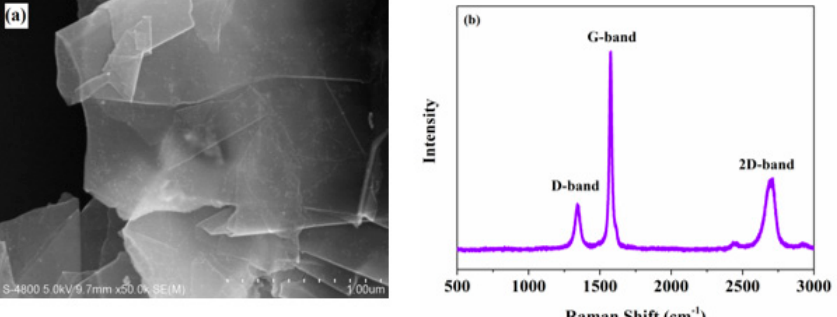
Figure 1. Structure images of few-layer graphene (FLG). ( a ) Scanning electron microscope (SEM) image; ( b ) Raman spectrum.